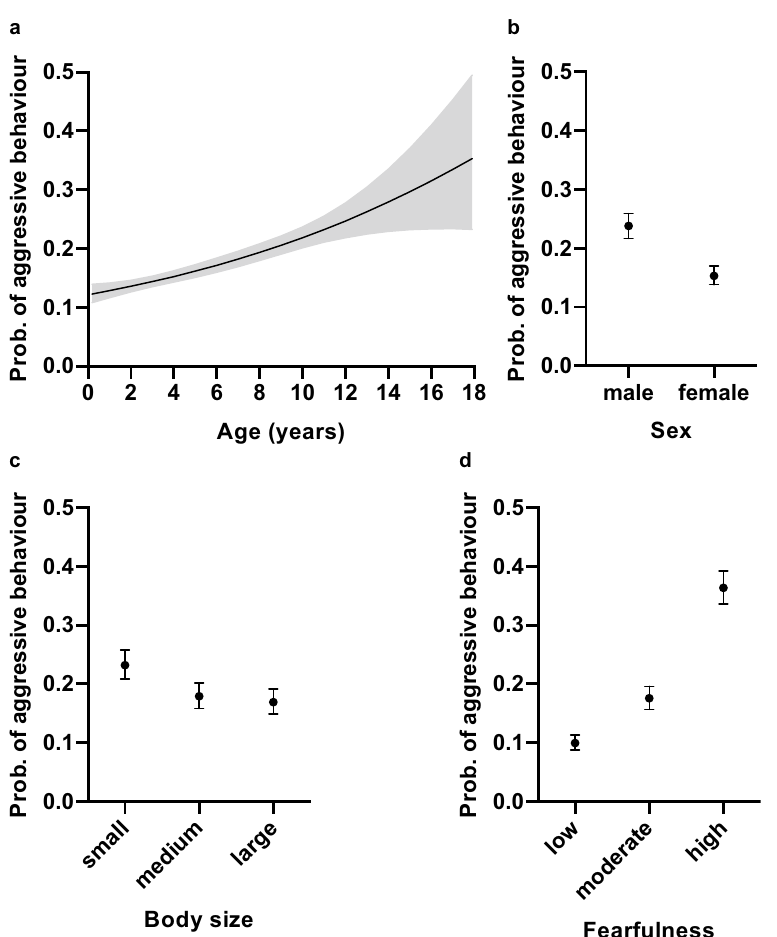
Figure 1. The effect of age, fearfulness, sex, and, body size on aggressive behaviour in the logistic regression analysis. ( a ) Older dogs had a higher probability of aggressive behaviour than young dogs. ( b ) Male dogs had a higher probability of aggressive behaviour than female dogs. ( c ) Small dogs had a higher probability of aggressive behaviour than medium-sized and large dogs. ( d ) Highly and moderately fearful dogs had a higher probability of aggressive behaviour than non-fearful dogs. Grey area ( a ) and error bars ( b – d ) indicate 95% confidence limits. N =